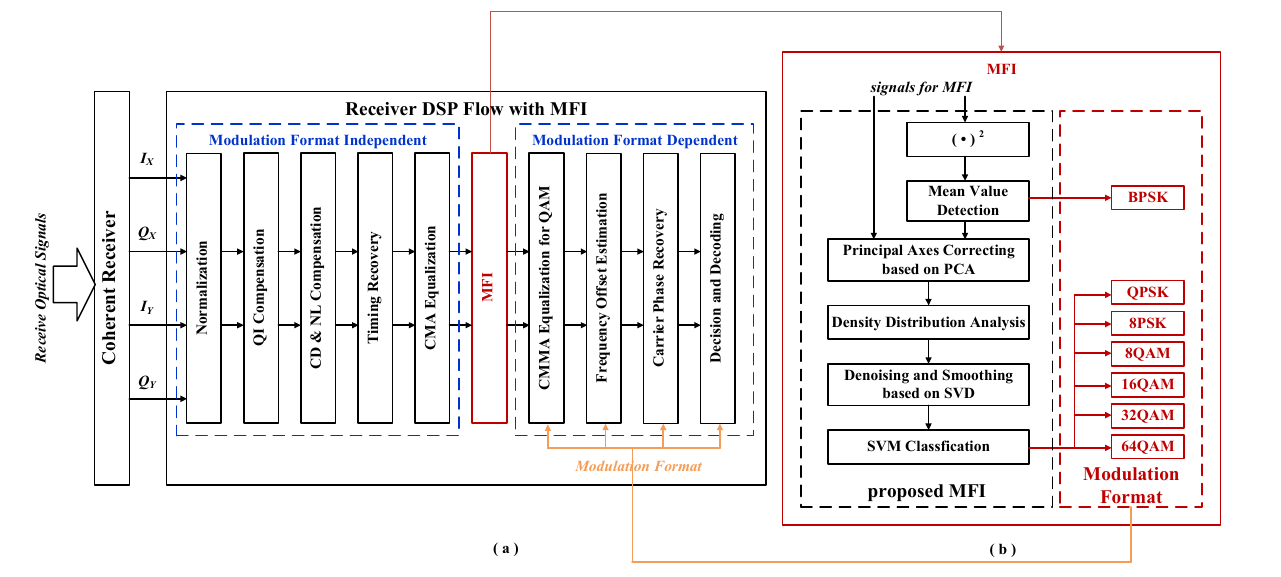
Figure 1. The DSP flow in optical digital coherent receive; ( a ) Receiver DSP flow with MFI; ( b ) The proposed MFI method based on PCA and SVD.